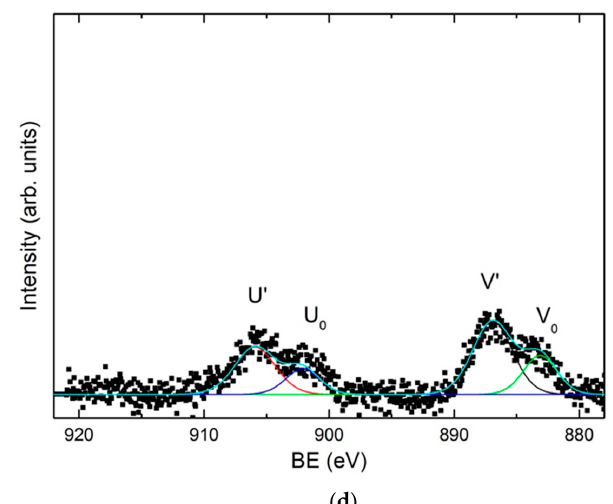
Figure 5. High-resolution X-ray photoelectron spectroscopy (XPS) spectrum corresponding to Ce 3d for: ( a ) dark gray area (zone I); ( b ) dark blue area (zone II-a); ( c ) dark blue area (zone II-b); and ( d ) light gray area (high current density extreme of zone III-a).